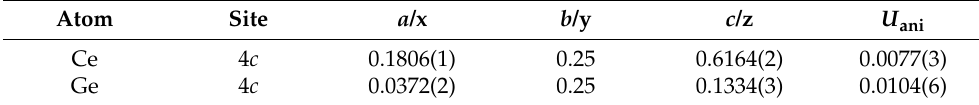
Table 4. Position and displacement parameters for CeGe.